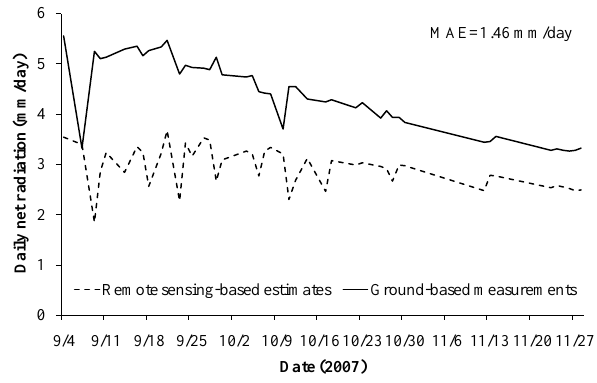
Fig. 8 . Daily net radiation time series of remote sensing-based estimates and ground- Fig. 8. Daily net radiation time series of remote sensing-based esti- based measurements at the SD-Dem site in 2007. mates and ground-based measurements at the SD-Dem site in 2007.